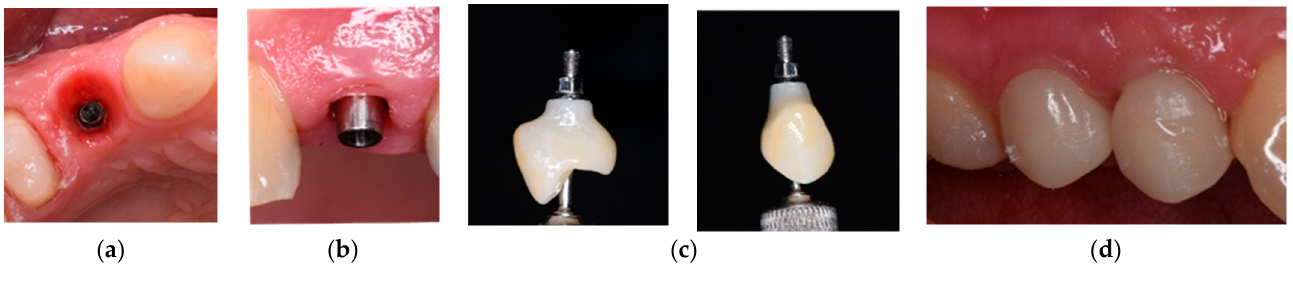
Figure 1. Prosthetic restoration used for Group A.